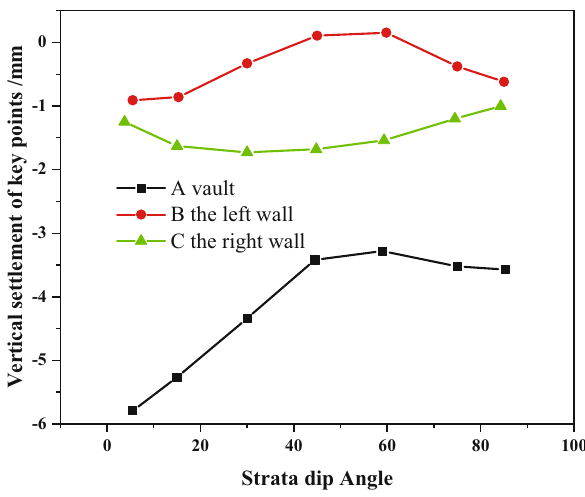
Figure 4: Vertical displacement curve 1 of key